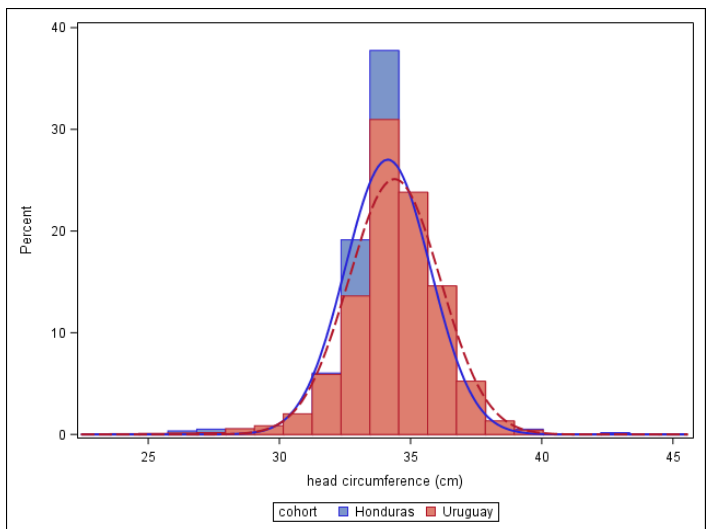
Figure 3. Distribution of head circumference in the Zika in Pregnancy in Honduras cohort (2016) and the Uruguay SIP surveillance system